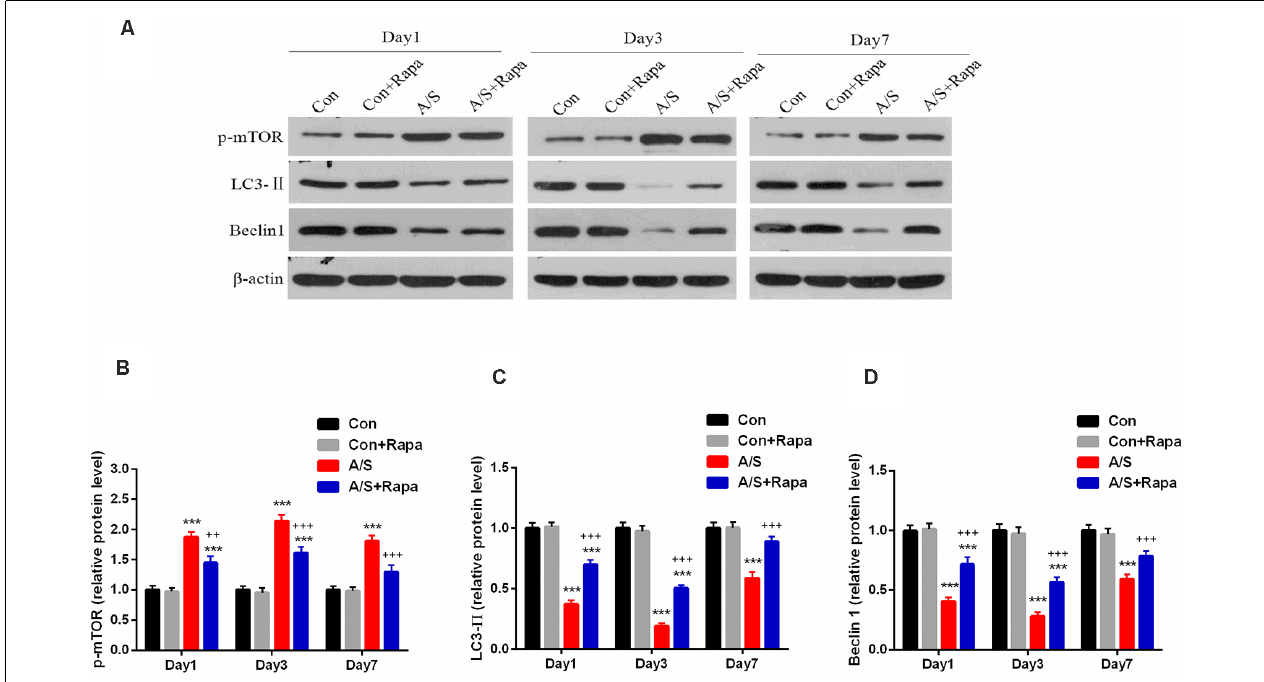
FIGURE 4 | Rapamycin treatment inhibited the abnormal p-mTOR and increased LC3-II and Beclin-1 levels in the hippocampus. (A) Representative western blot illustrating the effects of rapamycin on the anesthesia/surgery-induced changes in hippocampal p-mTOR, LC3-II and Beclin-1 levels on days 1, 3 and 7 after anesthesia/surgery. (B) Rapamycin reversed anesthesia/surgery-induced increase in p-mTOR expression in the hippocampus on days 1, 3 and 7 after anesthesia/surgery. (C,D) Rapamycin reversed anesthesia/surgery-induced decrease in LC3-II and Beclin-1 levels in the hippocampus on days 1, 3 and 7 after anesthesia/surgery. Data are mean ± SEM ( n = 6 per group). *** p < 0.001 vs. Con. +++ p < 0.001, ++ p < 0.01 A/S. Con, control group; Con+Rapa, control group with rapamycin pretreatment; A/S, anesthesia/surgery group; A/S+Rapa, anesthesia/surgery group combined with rapamycin